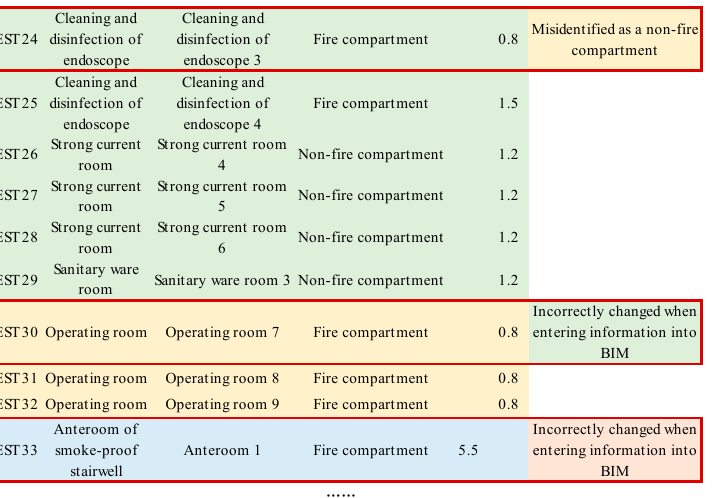
Figure 19. An excerpt from the detection error analysis table. The results of checking the safety compliance of building design documents with the above developed SWRL statement were compared with the database-based information retrievals and the traditional and manual information contradistinction methods. The comparison results are illustrated in Table